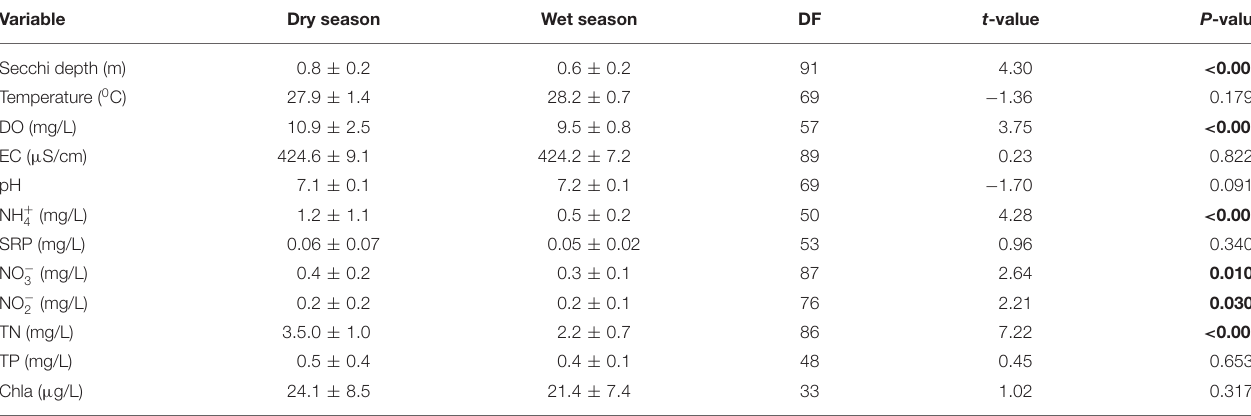
TABLE 1 | Mean values ( ± SD) of water quality variables and nutrient concentrations during the dry and wet seasons in Lake Kanyaboli, Kenya during the study period from February 2020 to February 2021. Variable